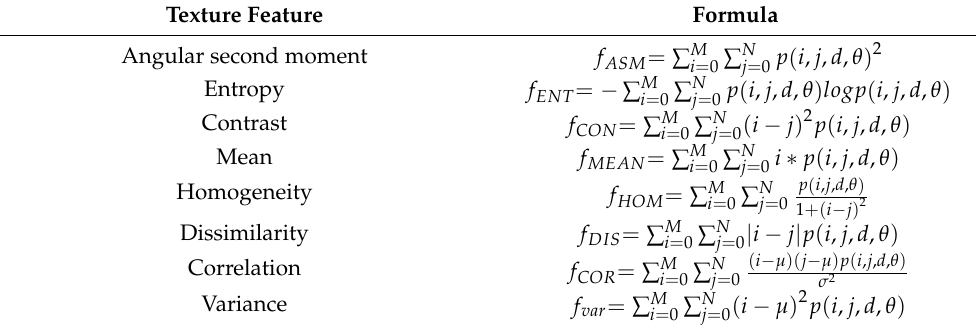
Table 2. Expressions for texture